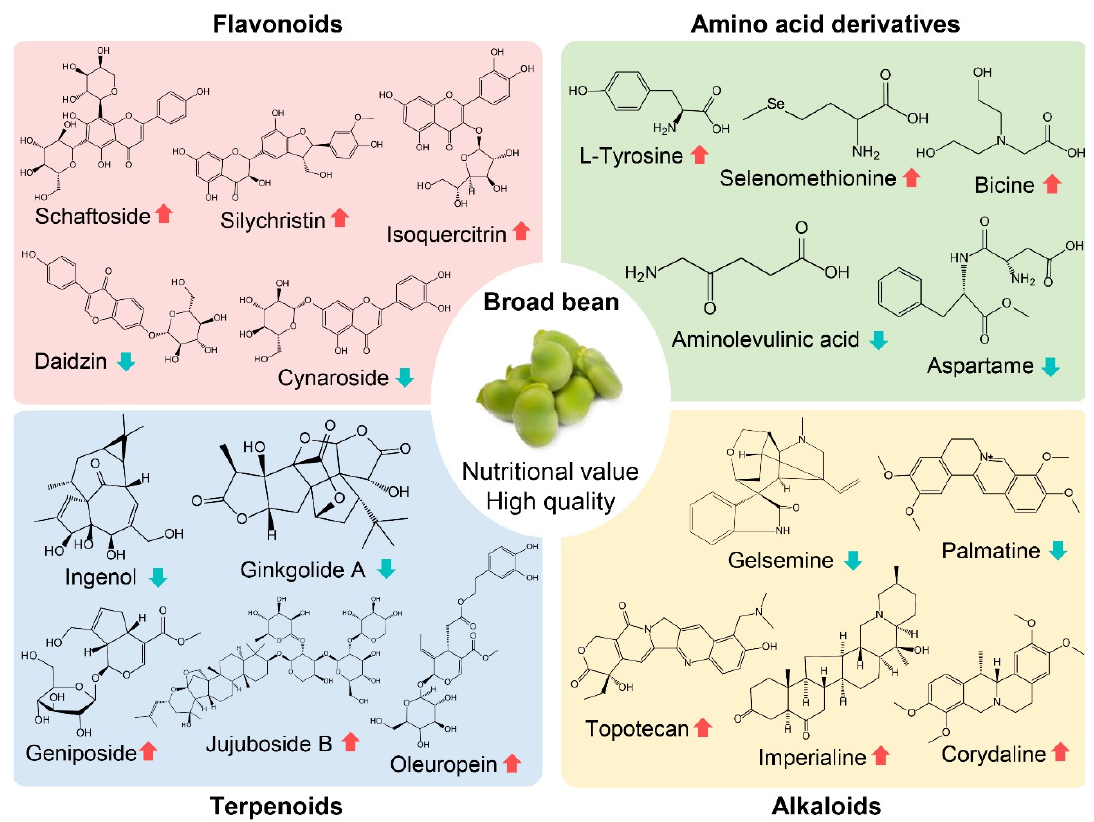
Figure 7. Key secondary metabolites related to quality, nutrition and stress resistance in broad bean. Arrows indicate up- (red) and down-regulation (cyan) of the corresponding metabolite in CX, respectively.